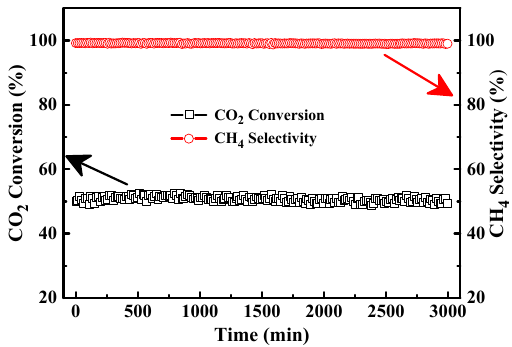
Figure 6. Stability of 50% Ni–La 2 O 3 –M in CO 2 methanation reaction at GSHV = 120,000 mL g − 1 h − 1 on stream at 300 °C and 0.1 MPa in H 2 /CO 2 /Ar = 4/1/5.